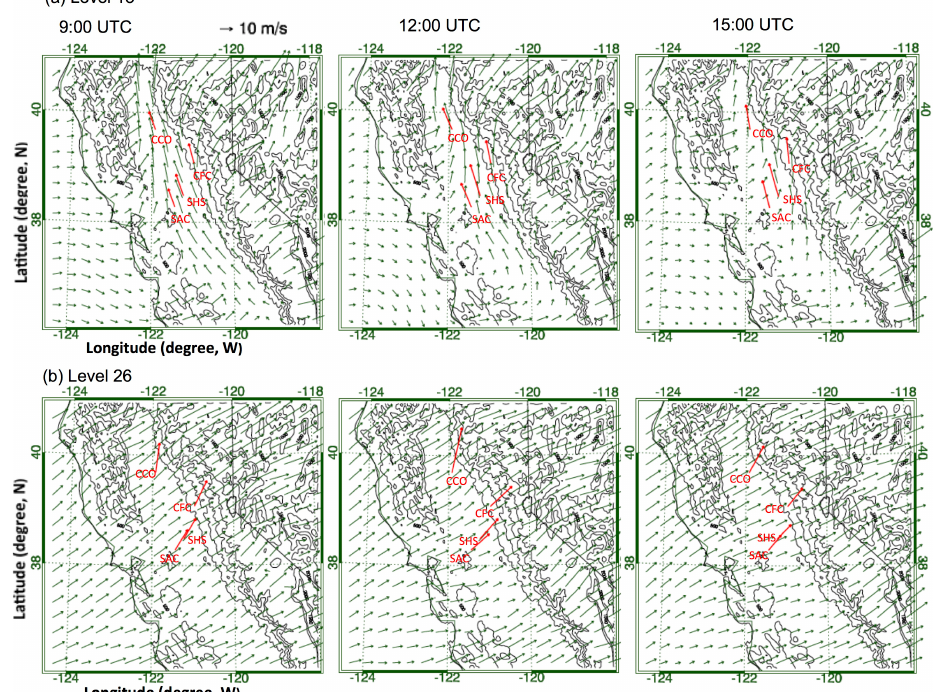
Fig. 14. Same as Fig. 12, only for MAR02.